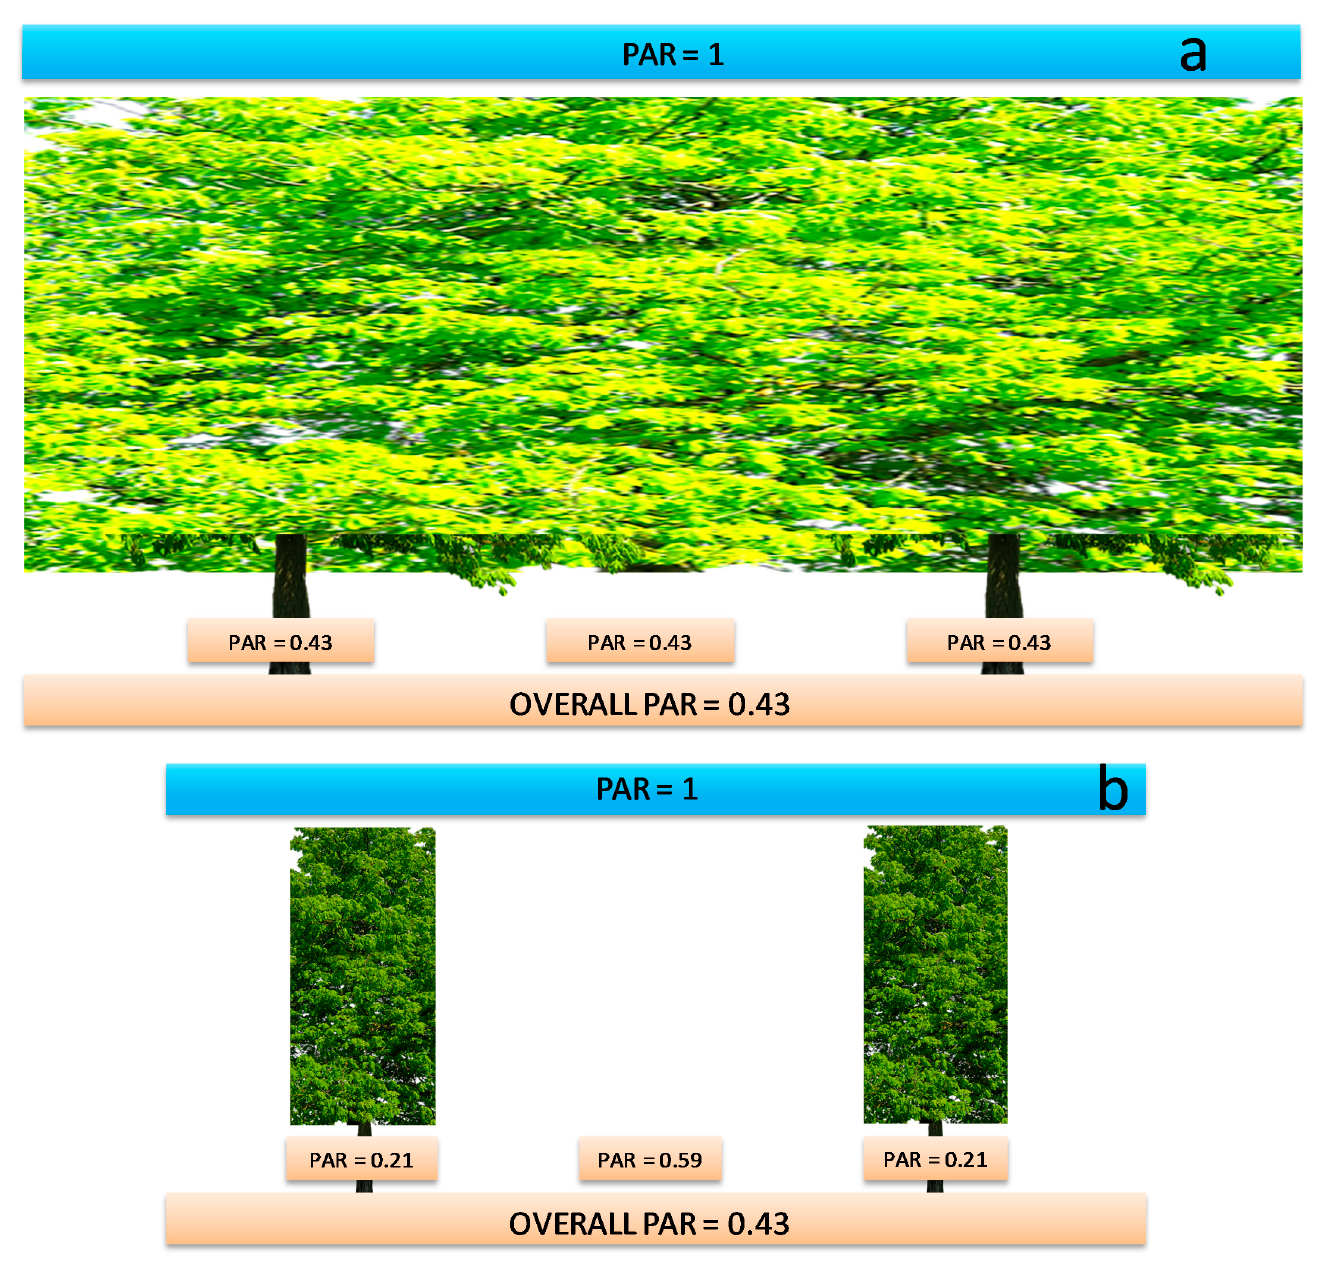
Figure 6. ( a ) Theoretical canopy with perfectly uniform horizontal canopy cover. In this canopy, the PAR transmitted on the orchard floor is uniformly distributed in space and is assumed to be 0.43 (i.e., the same found for the SHD system in this experiment). ( b ) Canopy of the SHD system in this experiment, with actual values of PAR transmission under the trees (PAR = 0.21 under the tree row; PAR = 0.59 in the alley centers) as measured in this experiment. In this situation, while the overall PAR transmittance (and therefore PAR interception) is the same as in the top figure (overall transmitted PAR = 0.43), the irradiance below the tree row is less than half (i.e., 0.21 vs. 0.43).